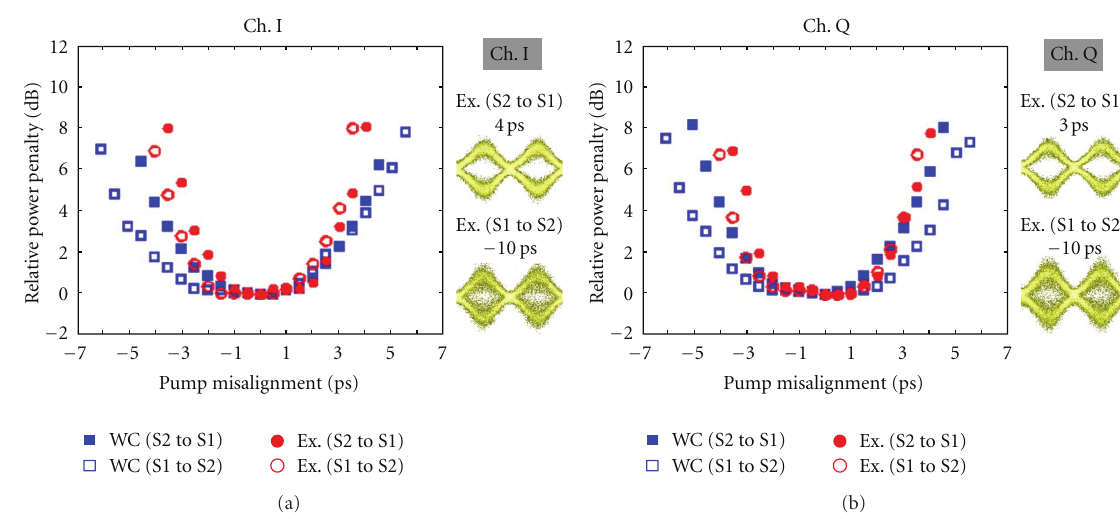
Figure 18: Impact of pump phase misalignment on the exchange performance for 100 Gbit/s DQPSK data